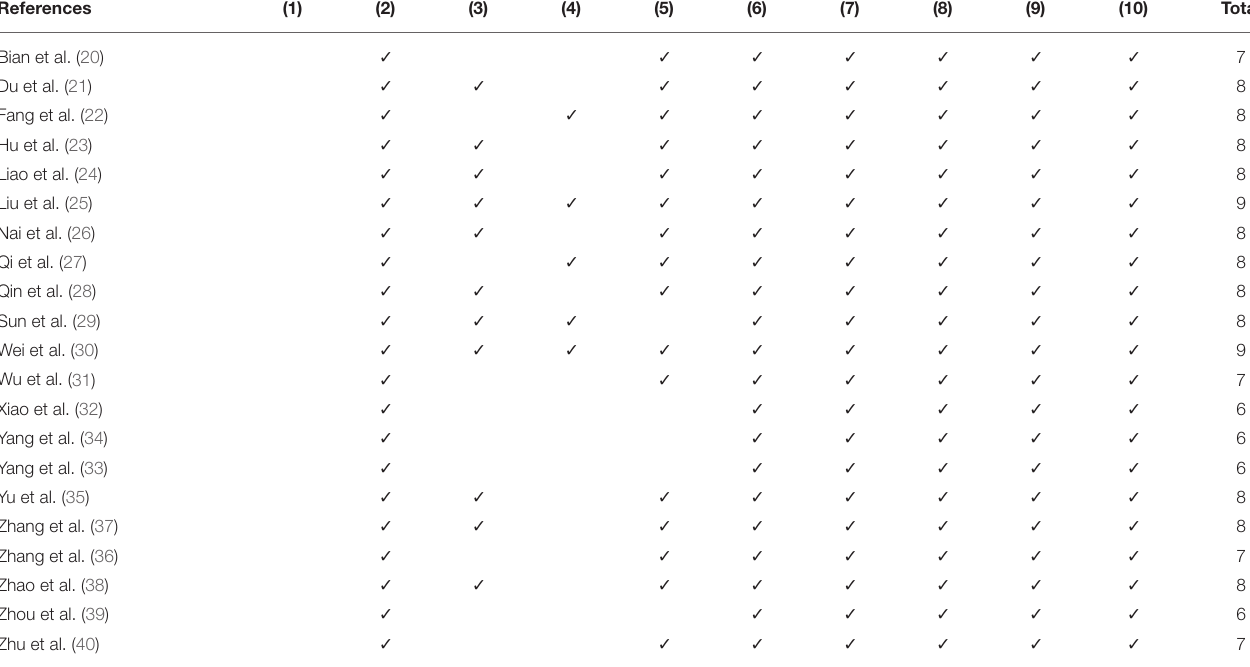
TABLE 3 | Risk of bias of included studies according to CAMARADES checklist.